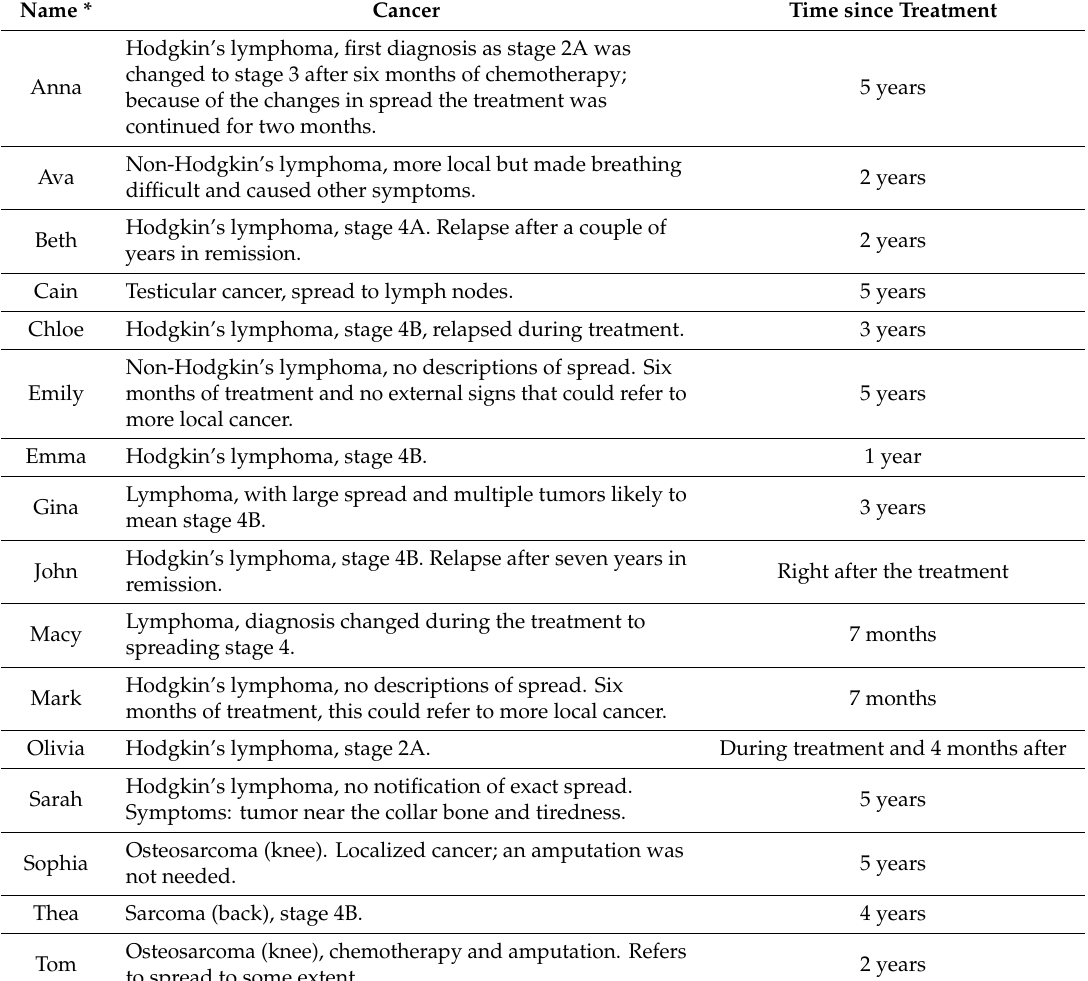
Table 1. Participants and descriptions of their